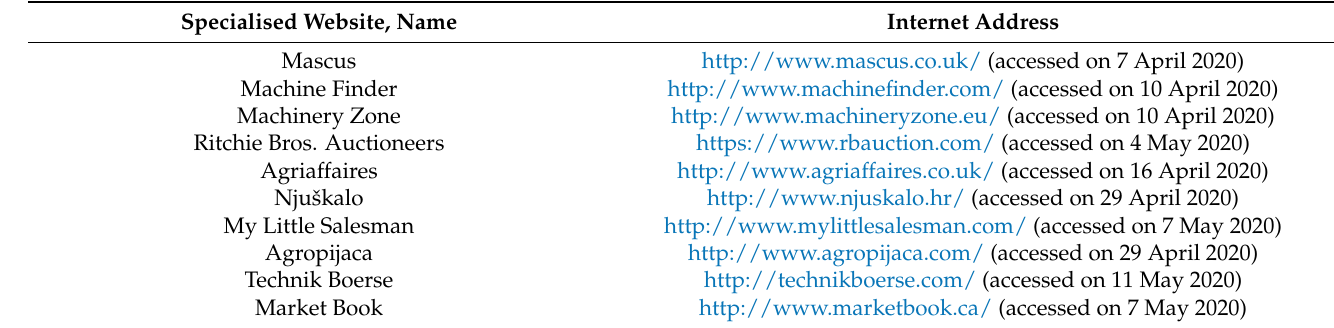
Table 1. List of data